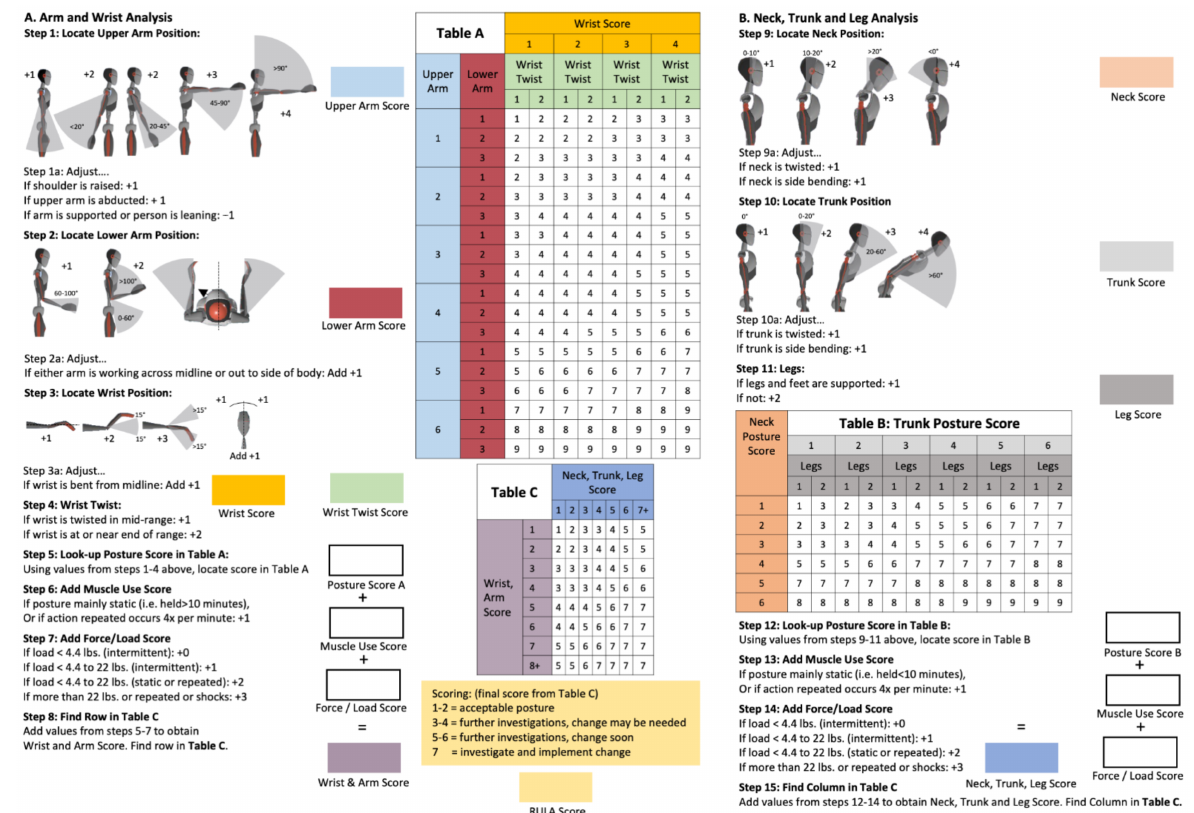
Figure 2. The Rapid Upper Limb Assessment (RULA) worksheet